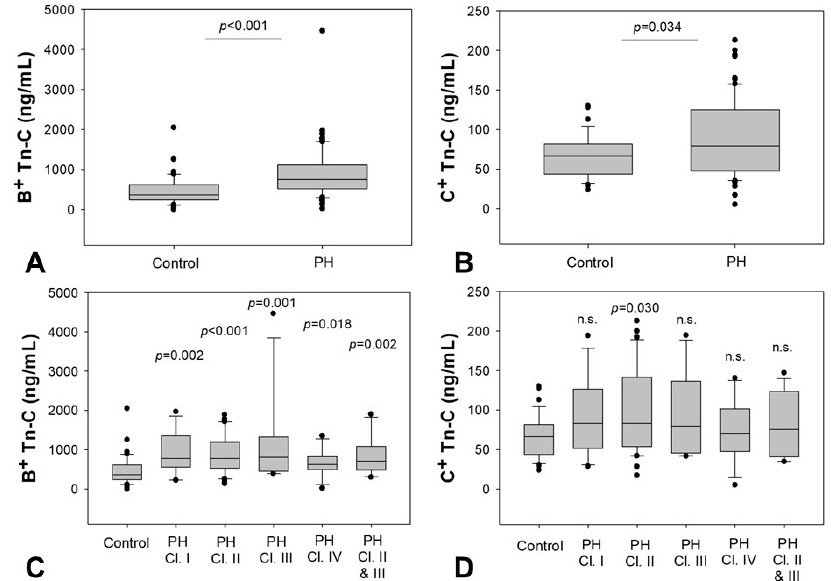
Figure 1. Increased serum levels of B + and C + Tn-C in patients with pulmonary hypertension (PH) compared to healthy controls. ( A ) shows the results for B + Tn-C, ( B ) for C + Tn-C; ( C , D ) show the subgroup analyses with respect to the PH etiology, PH classes are named according to the classification of the current guidelines. The box plots indicate the median (line inside the box), 25 and 75 percentile (lower and upper boundary of the box), 10 and 90 percentile (whiskers outside the box) as well as outlier values (dots). Cl. = class, Tn-C = Tenascin C.